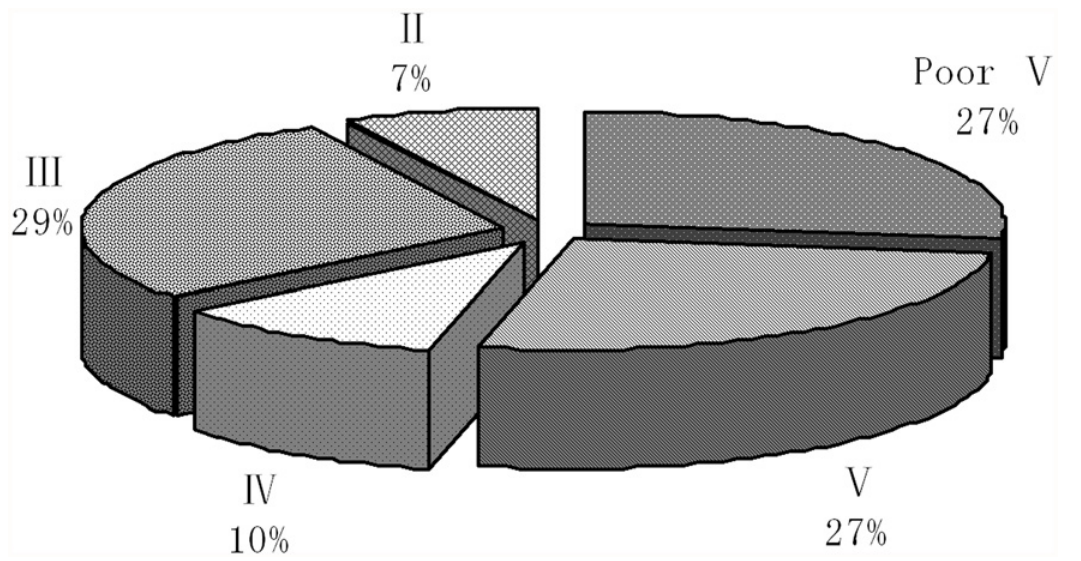
Fig 2. The proportional graph of water quality levels in the Honghe River Watershed. indices for NH -N, NO -N, TP, TN, and DO were processed with GIS, geostatistical methods. 3 2 Two evaluation criteria such as Mean Standardized Prediction Error (MSPF) and Root Mean Square Standardized Prediction Error (RMSS) were applied to recognize appropriate geostatis- tical method of spatial interpolation. The closer to 0 for MSPF and 1 for RMSS, the more preci- sion it is. According to experimental results of different geostatistical methods of spatial interpolation, the most efficient and prominent method for observed data was the Ordinary Kriging (OrKrig) [33]. These evaluate results which were obtained by OrKrig interpolation method are best and acceptable, as the Table 5 shows here below: -N. From Fig. 3a illustrated the spatial variability of the single factor pollution index of NH 3 -N pollution in the study area can be recognized and five these maps, the dispersion of NH 3 major zones with NH -N pollution over the watershed can be found. The first zone, defined as 3 non-pollution area, located surrounding the Wugang, Queshan and Suiping counties, almost covered more than half of the study area (62.14%) as indicated in Table 6. The second zone, de- fined as slightly polluted area, mainly concentrated in Zhentouhe and Honghe tributary river sections, covered about 24.04% of the study area. The third zone, defined as moderately pollut- ed area, were separated one from another by miles of open land to the northwest, north-central, east and middle parts of the study area, covered 8.62% of the study area. The fourth zone was